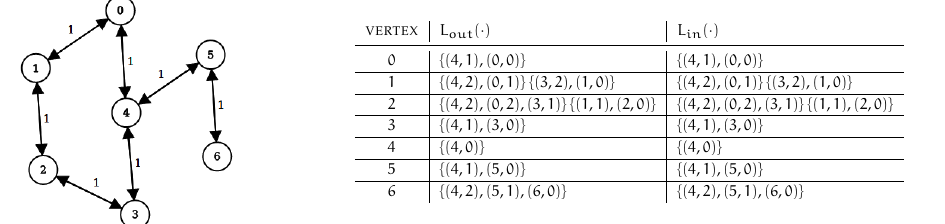
Figure 2. Consider the graph of Figure 1 ( left ) and the corresponding labeling ( right ). Assume arc ( 4 , 0 ) is removed. If Algorithm BIDIR –2 HC is executed, vertices 3 , 5 , 6 have their label sets scanned twice, once during the detection of affected vertices and once during the removal phase, since hub vertex for pairs ( 3 , 0 ) , ( 5 , 0 ) and ( 6 , 0 ) is vertex 4 . However, no label entry is removed from L in ( 3 ) nor from L out ( 3 ) (the same hold for label sets of L in ( 5 ) , L out ( 5 ) , L in ( 3 ) , L out ( 3 ) ). Our algorithm instead scans these label sets only